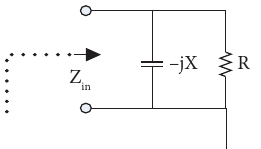
Figure 1: Capacitance and resistance in parallel.